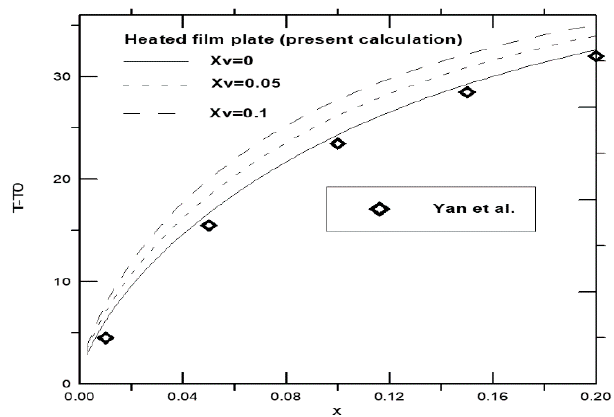
Figure 2. Validation of the code simulation. Interfacial temperature – comparison with Yan et al.